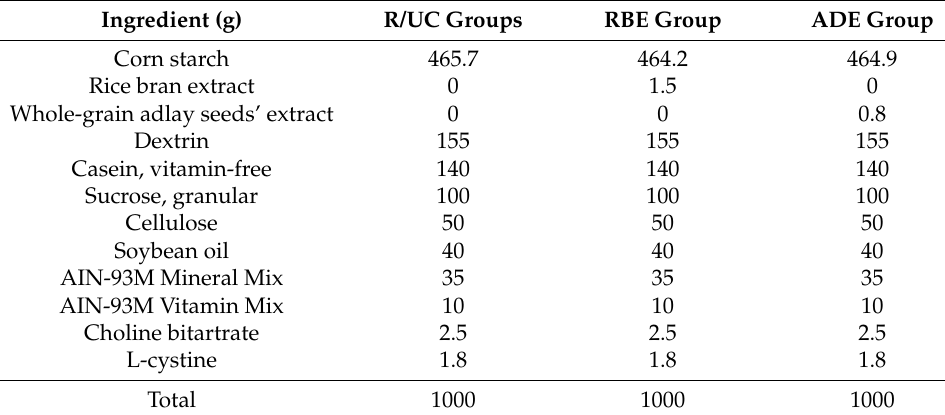
Table 1. Composition of AIN-93M-modified